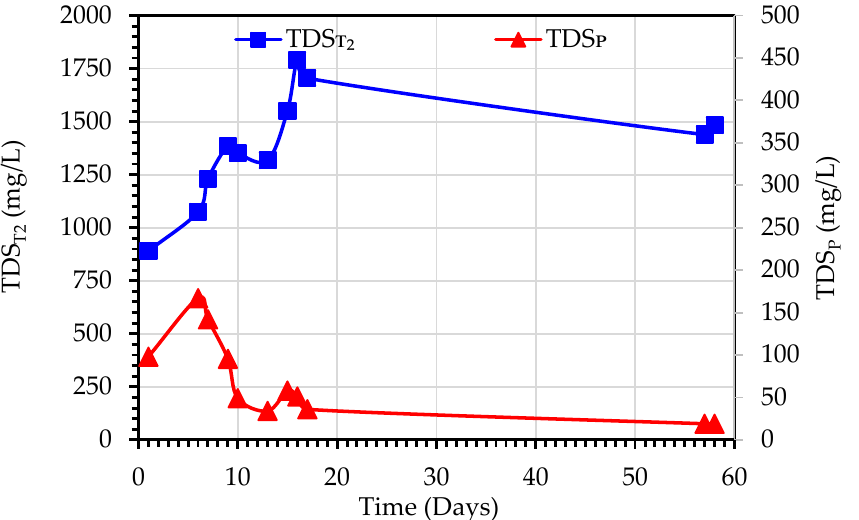
Figure 11. Variations of TDS values observed during the treatment of secondary wastewater using a hybrid DCMD system (Experiment 3).